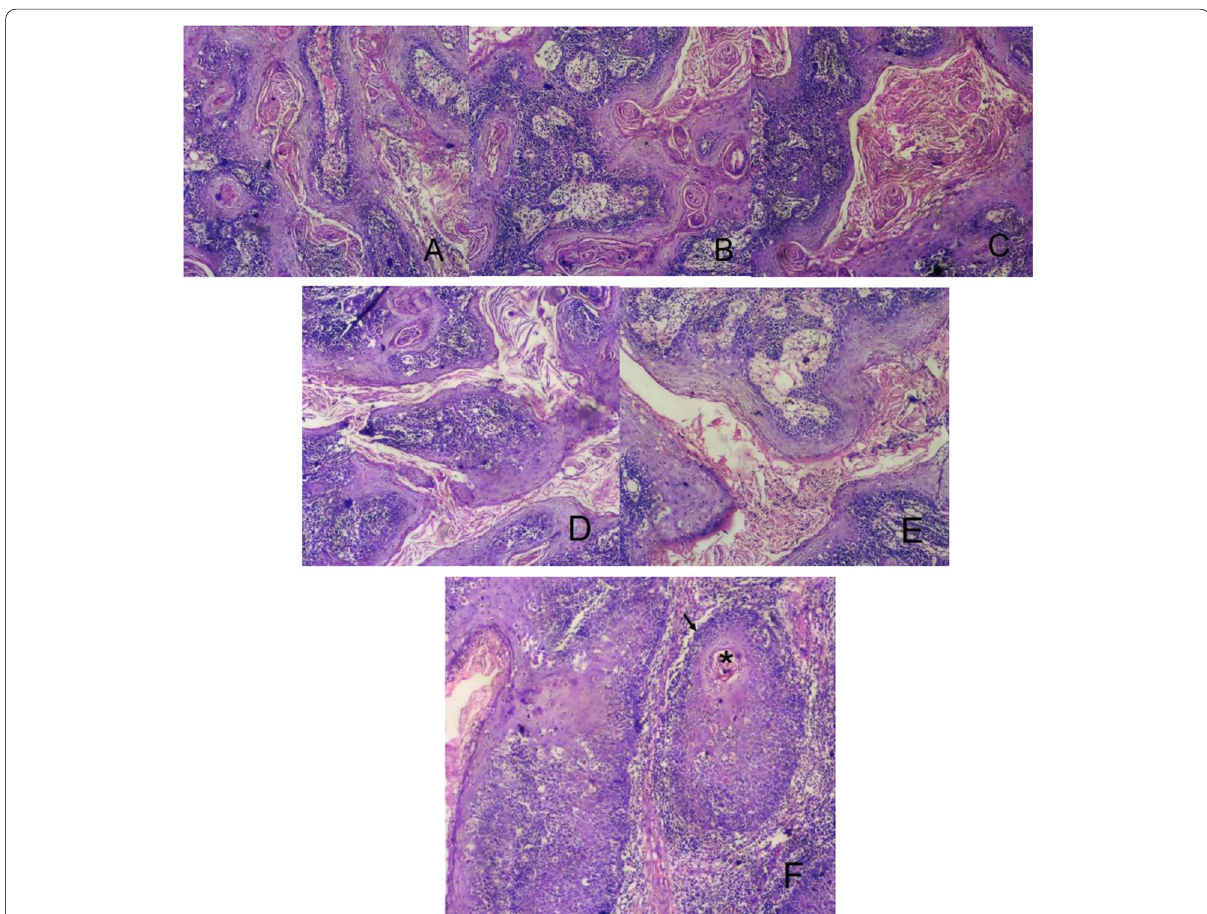
Fig. 2 Photomicrographs, hematoxylin and eosin (H&E) staining, showing A , B endophytic deep “burrowing” growth of neoplastic epithelium with keratin-filled crypts ( 100). C A higher magnification ( 200). D , E Neoplastic cells forming cyst-like sinuses and tracts filled with keratin debris ( × × 100). F Neoplastic islands. Arrow points to the tumor nest and * indicates the keratin pearls ( ×